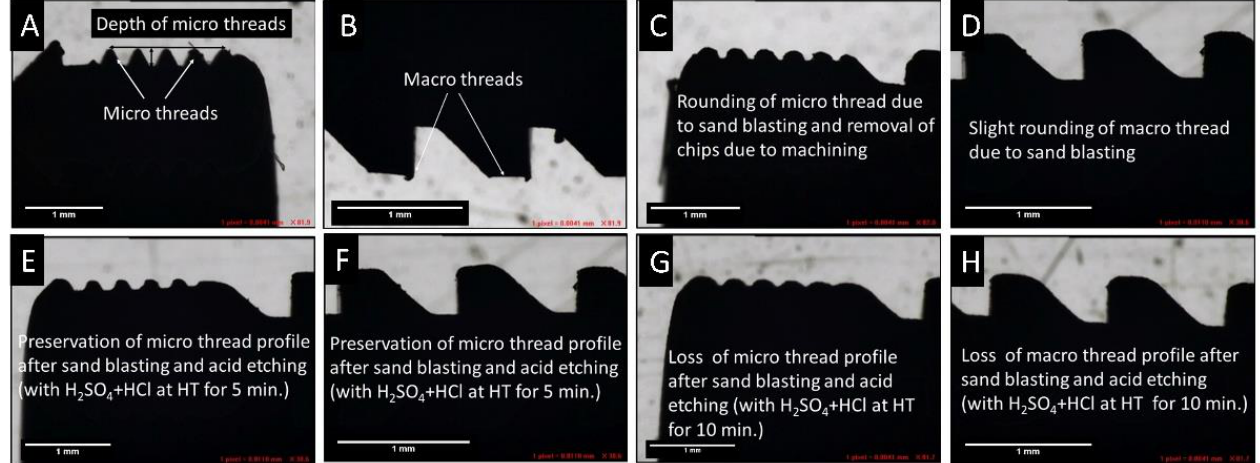
Figure 7. Profile images of dental implants under vision microscope: ( A , B ) machined implant, ( C , D ) sandblasted implant, ( E , F ) etched at HT for 5 min, ( G , H ) Etched at HT for 10 min.